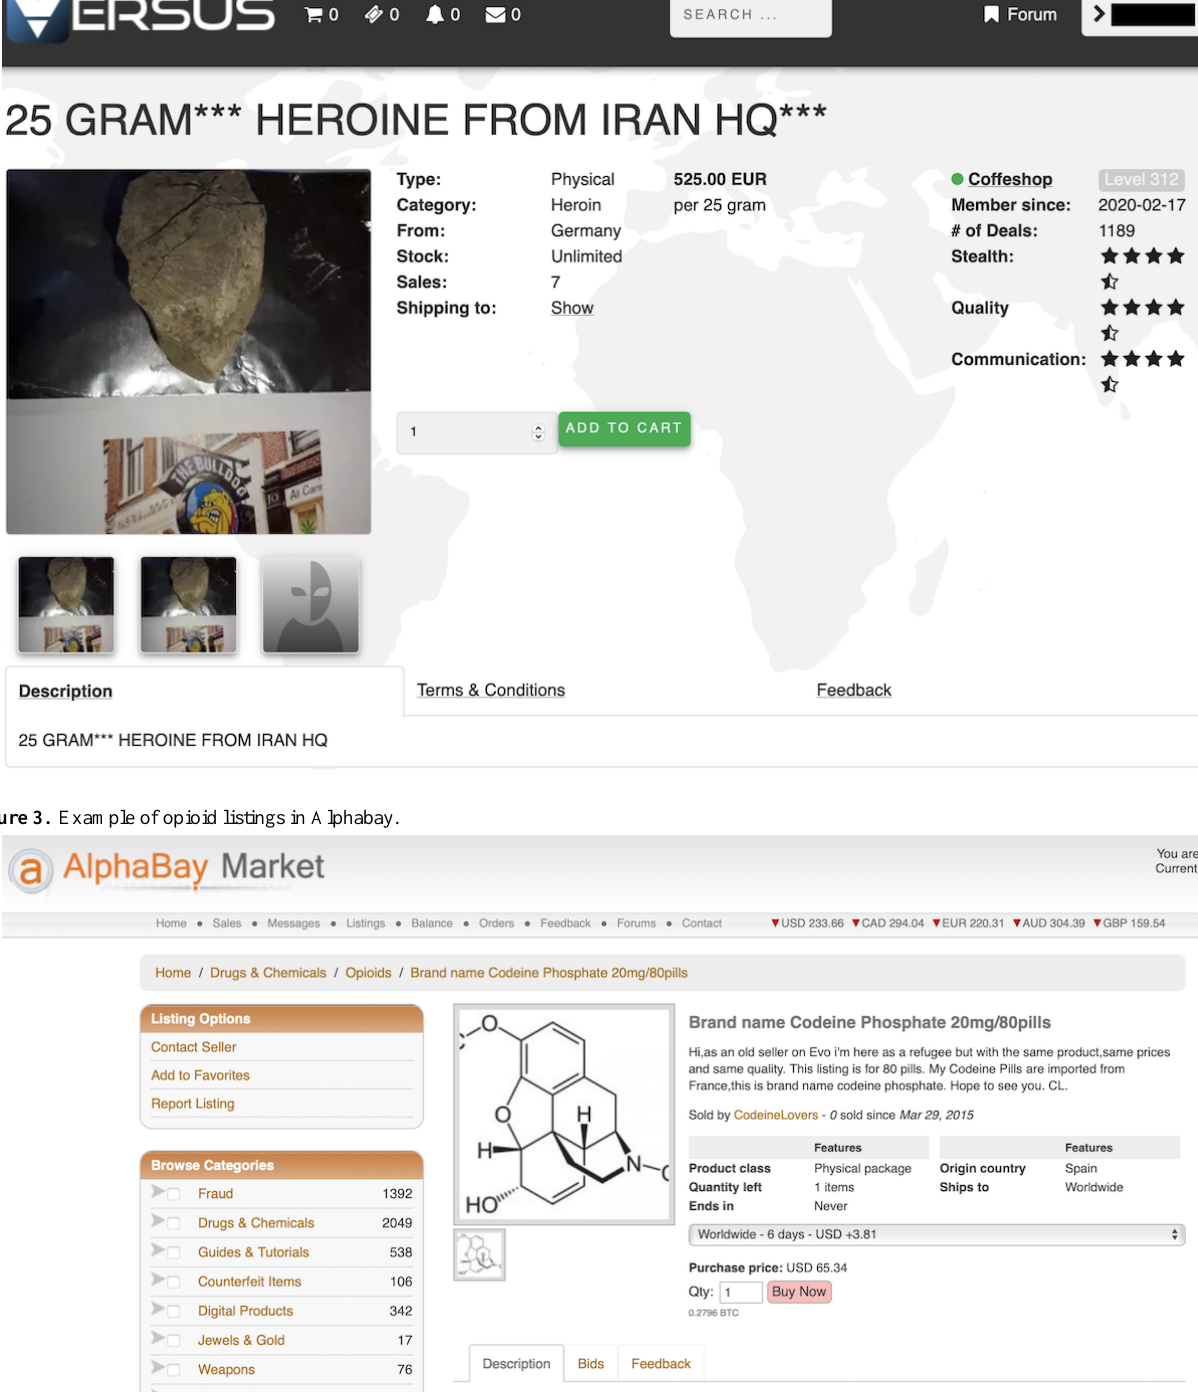
Figure 2. Example of opioid listings in The Versus Project.